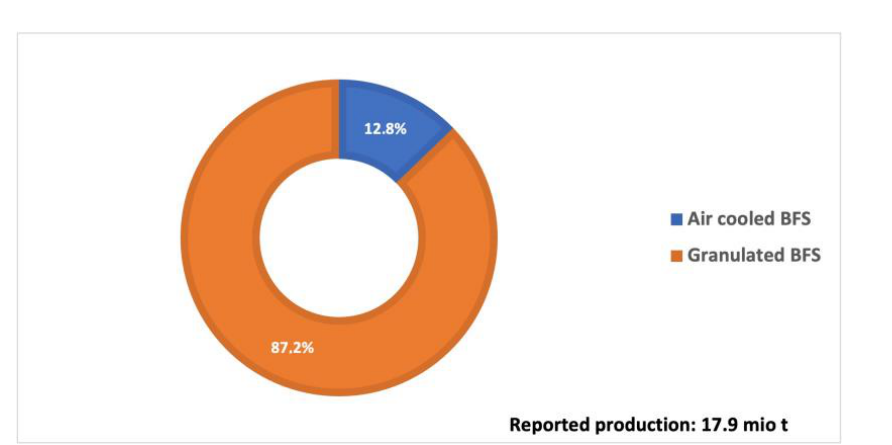
Figure 2. Production of steel slags in Europe in 2021 [4]. The utilization rate of slags depends on slag type, country or individual steelworks. According to Euroslag [4], in 2021 in Europe, all BF slag was used as cement/concrete addition [9], in road construction [10] or in other applications (Figure 3). In addition, about 76% of steel slags were used in cement/concrete addition [11], road construction, hydrau- lic engineering, fertilizer, metallurgical use or other applications [12] (Figure 4). Figure 3. Use of BF slag in Europe in 2021 [4].